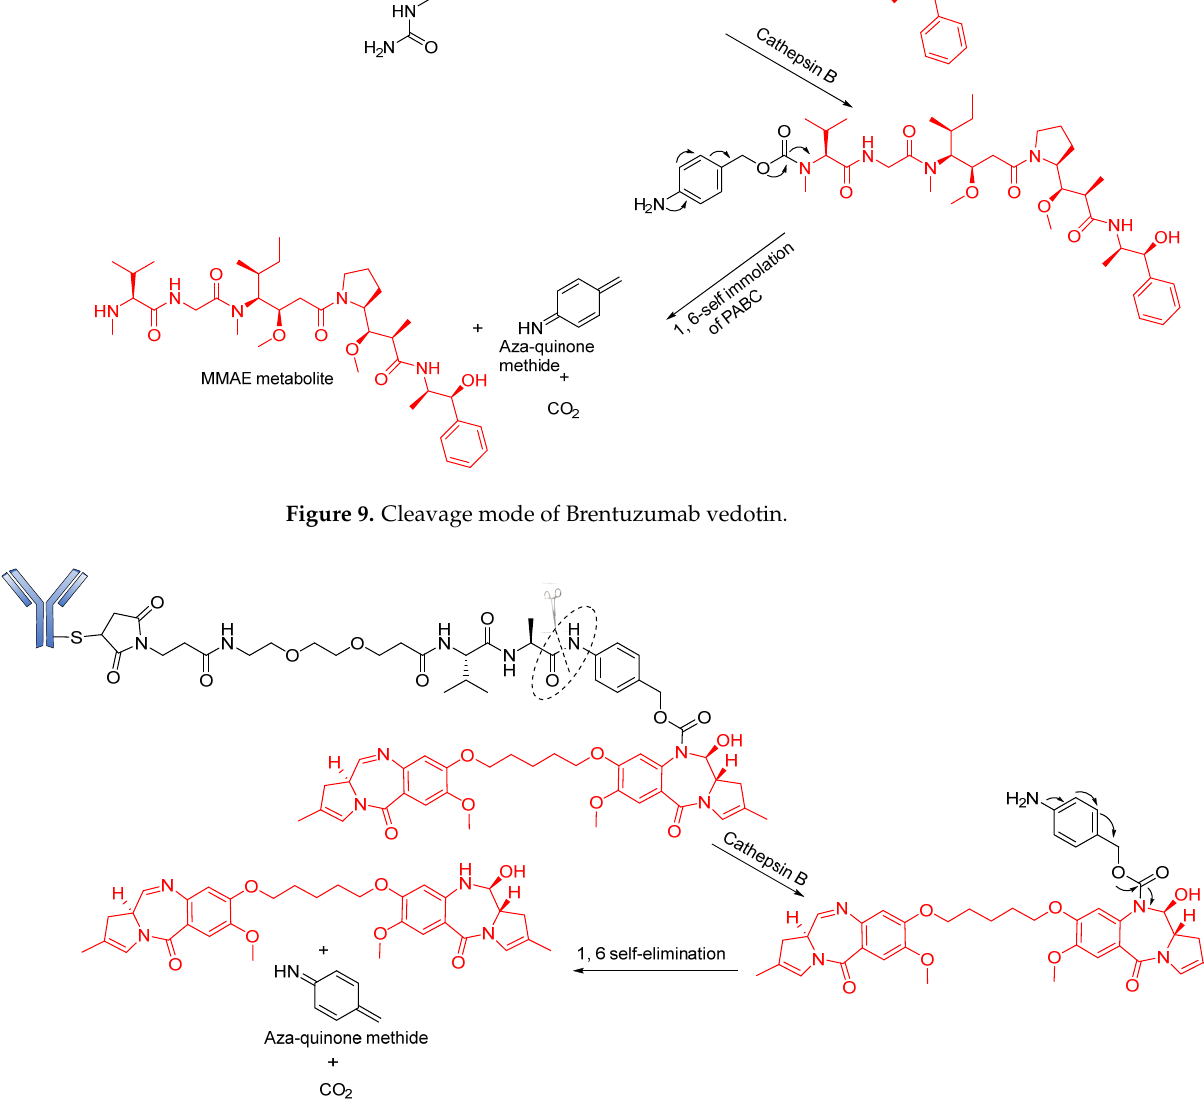
Figure 10. Cleavage mode of Val–Ala-containing Rovalpituzumab tesirine.